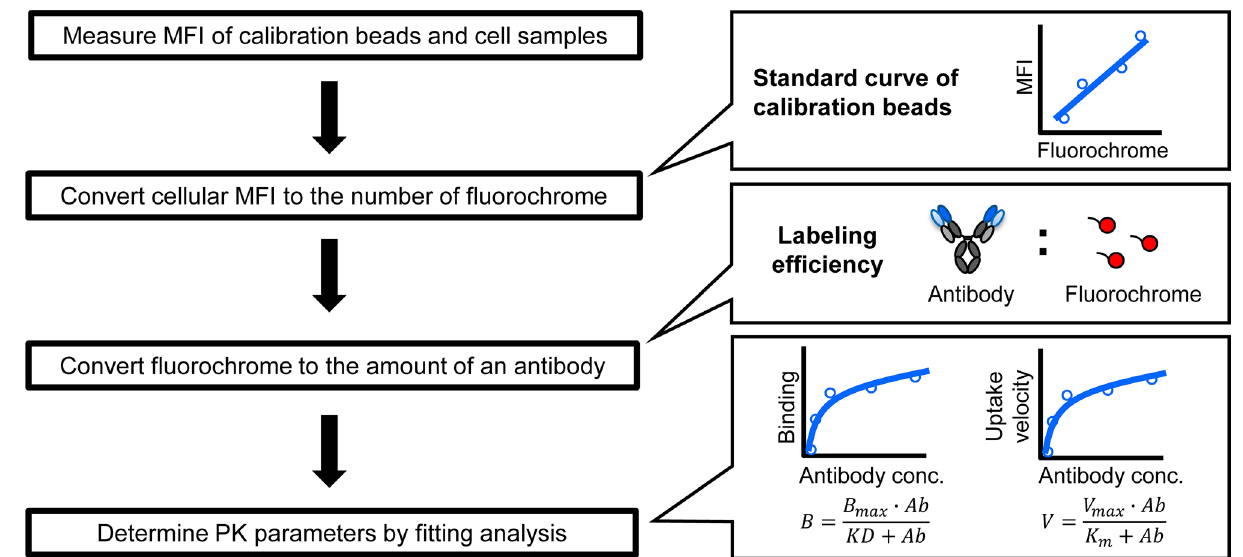
Figure 3. Schematic chart for determining PK parameters in in vitro cell-based assay using flow cytometery. The diagram shows the research flow for determining the amount of the cellular bound and internalized antibody by flow cytometer, and for estimating the PK parameters. MFI, mean fluorescence